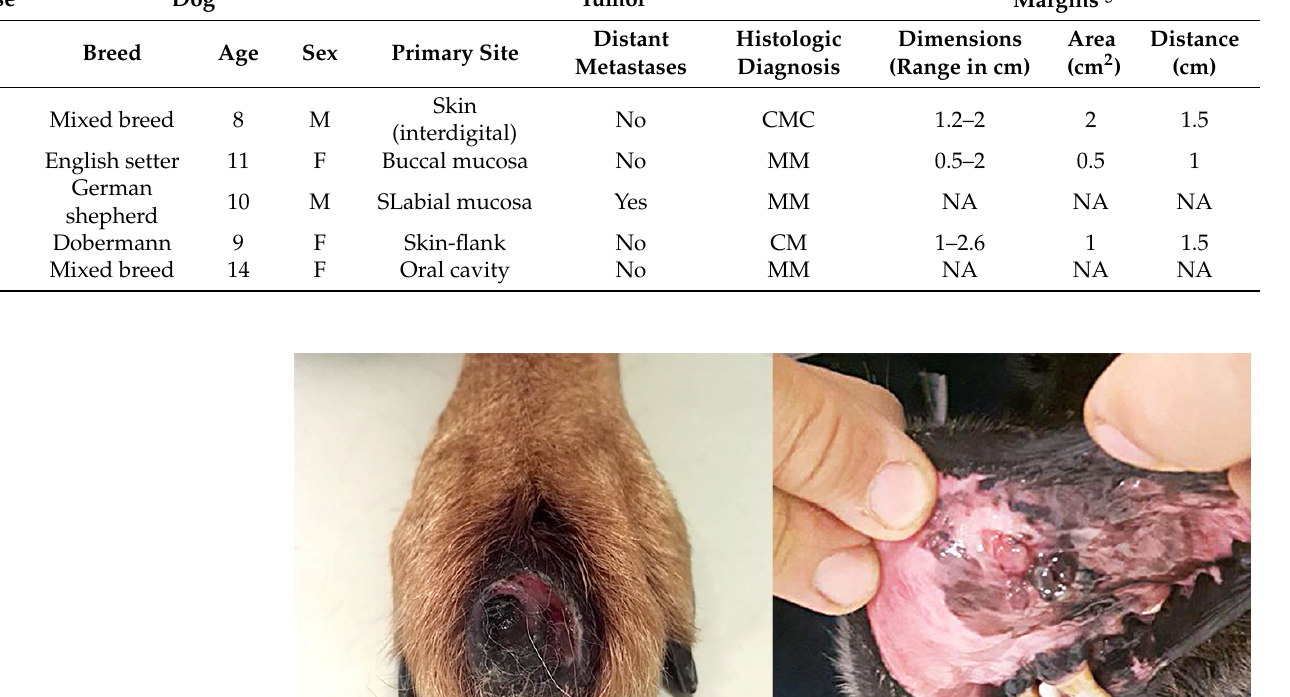
Table 1. Anamnestic data and histologic diagnosis of selected cases of canine melanocytic tumors. CMC = cutaneous melanocytoma; MM = mucosal melanoma; CM = cutaneous melanoma; NA = Not Available (only the neoplastic cells were cultured). § Dimensions = range of the minimum and maximum distance of the margins from the tumor. Area = cutaneous or mucosal surface used for normal tissue culture. Distance = centimeters from the tumor where the sample for normal tissue culture was taken.